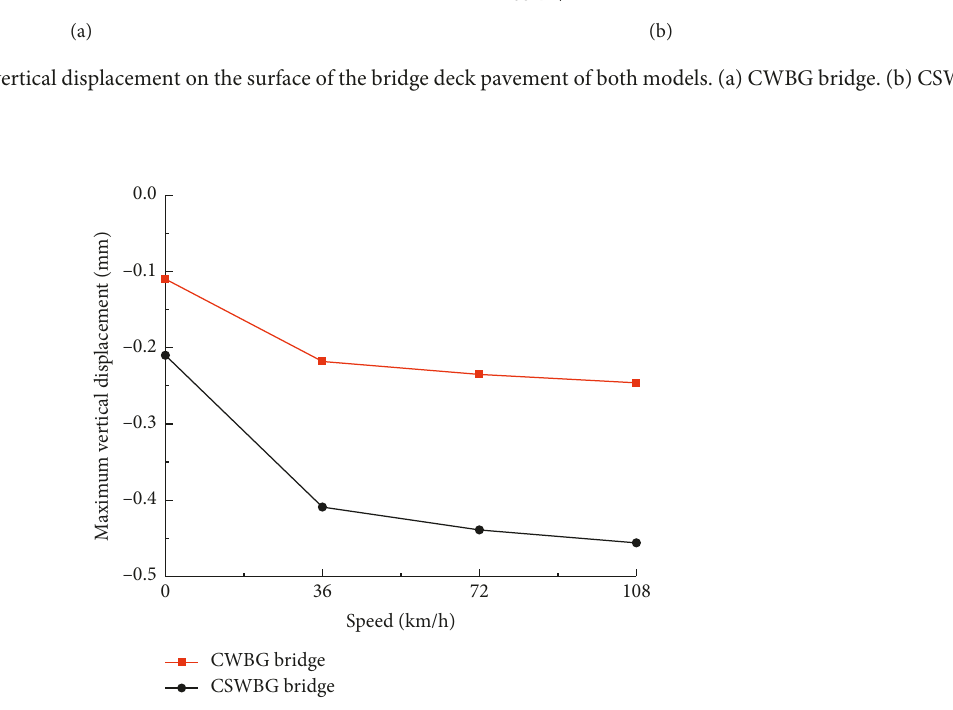
Figure 12: Comparison of maximum vertical displacement on the surface of the bridge deck pavement under double wheel